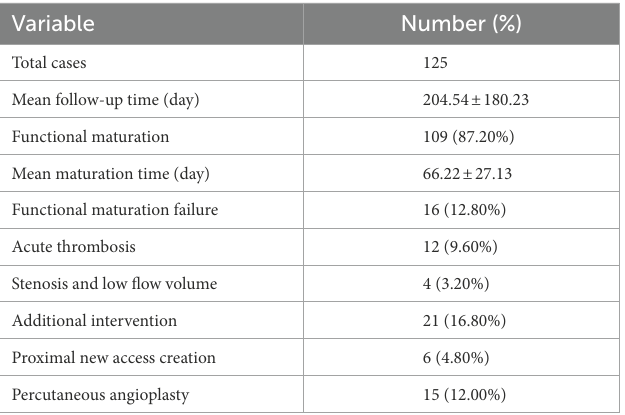
TABLE 2 Follow-up outcomes of the arteriovenous